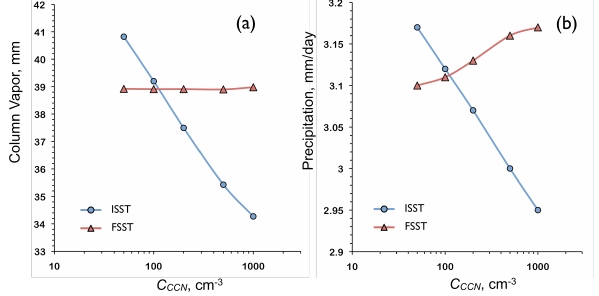
Fig. 4. Dependence of (a) column-integrated water vapour (precip- itable water), and (b) surface precipitation on CCN number con- centration at 1% supersaturation in simulations with fixed (red) and interactive (blue)